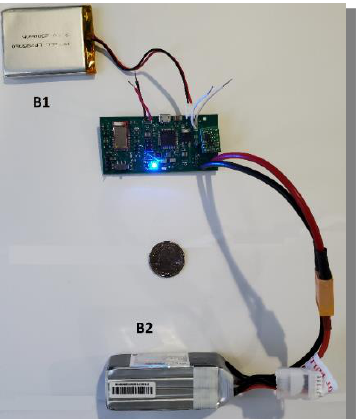
Figure 8. Photo of the final PCB with two batteries, B1 and B2. The 3.7 V battery (B1) powers the microcontroller and Bluetooth module. The 14.8 V battery (B2) powers the solenoid.